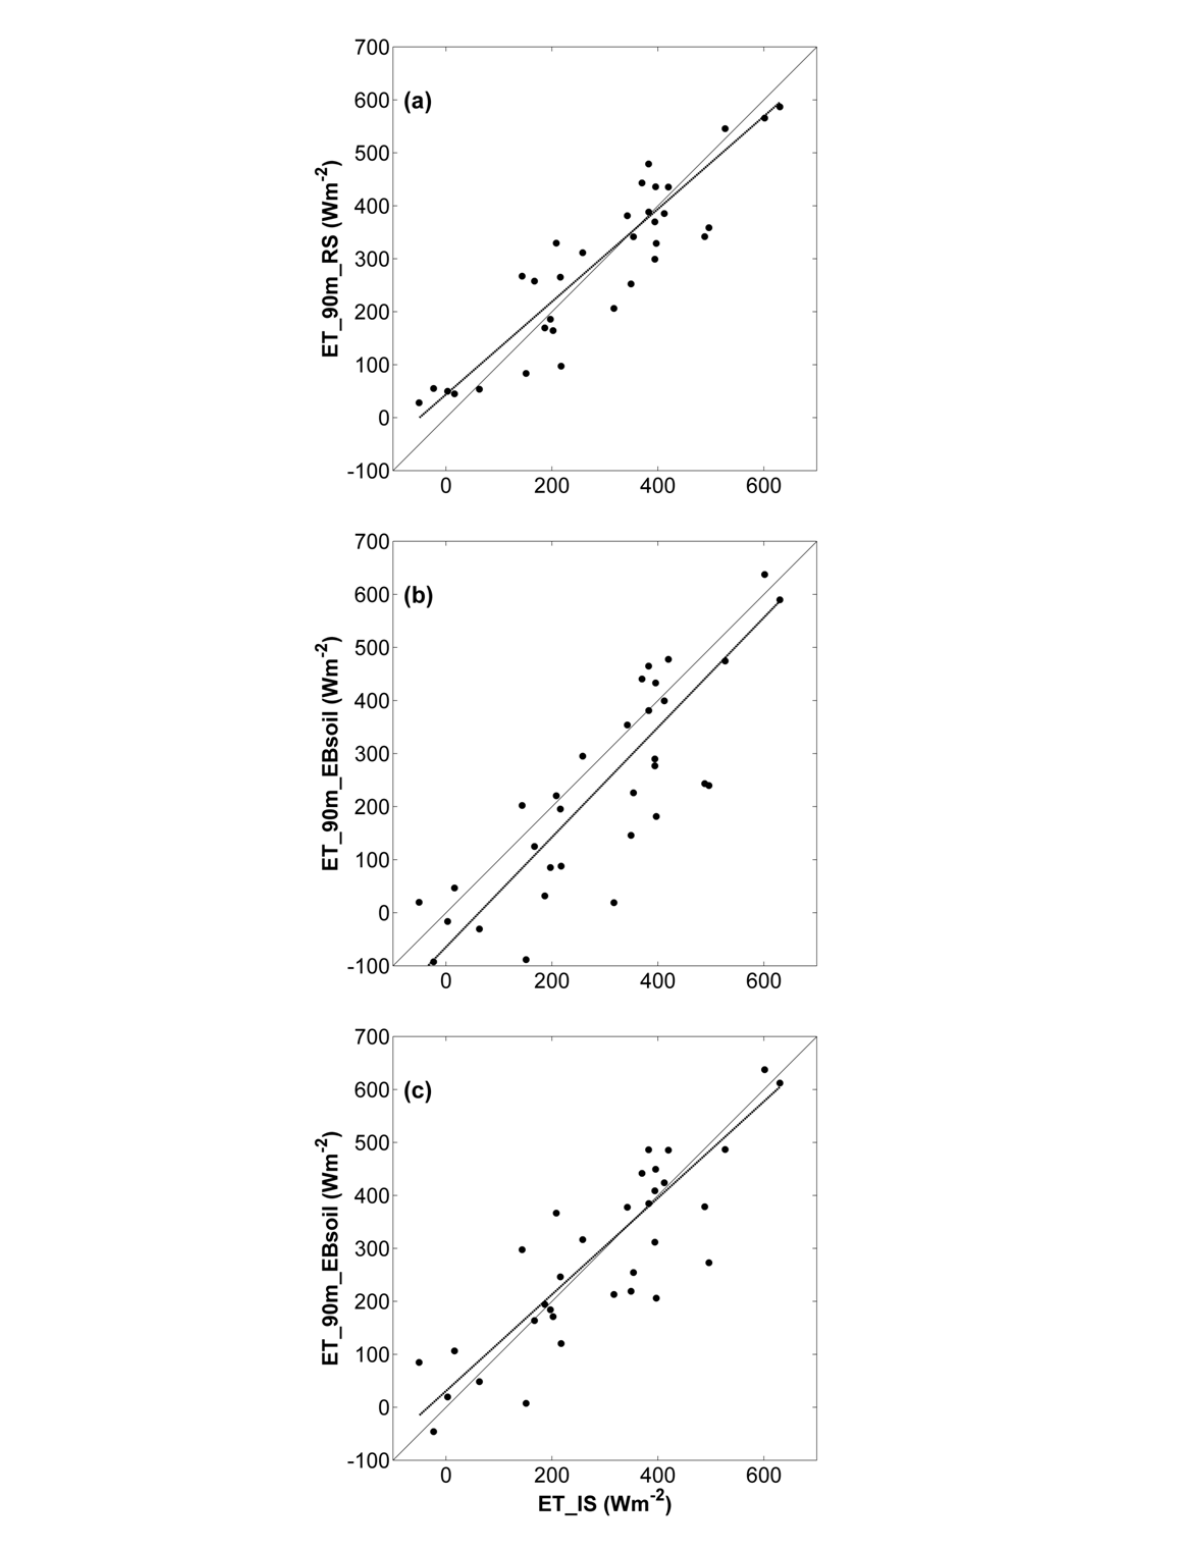
Figure 11. The ET simulated at 90-m resolution is plotted against station measurements for data over the Yaqui region. The Tends used as input to the EF_SEB-1S model consist of ( a ) the Tends retrieved from 90-m resolution data, ( b ) the Tends simulated by EBsoil with the RI and ( c ) MO aerodynamic